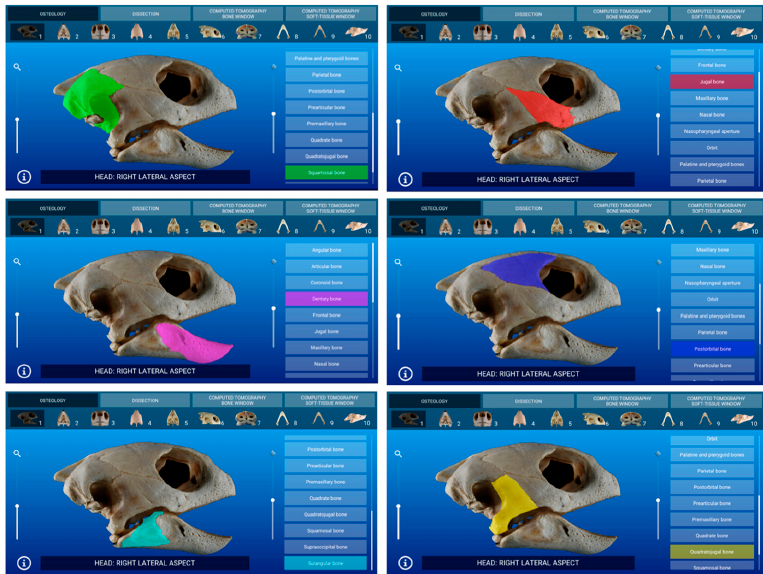
Figure 5. Atlas osteology section: an interactive image of the skull is shown in right lateral aspect.